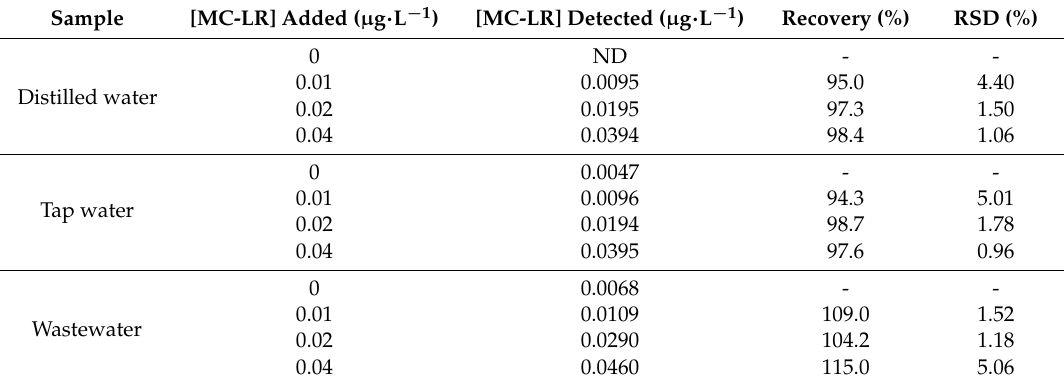
Table 1. Real sample aptatoxisensor analysis.